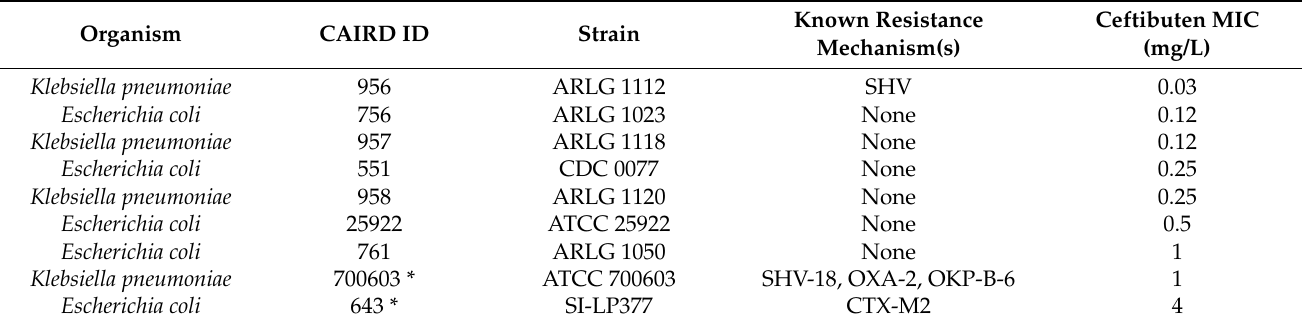
Table 4. Genotypic and phenotypic profiles of ceftibuten against the test